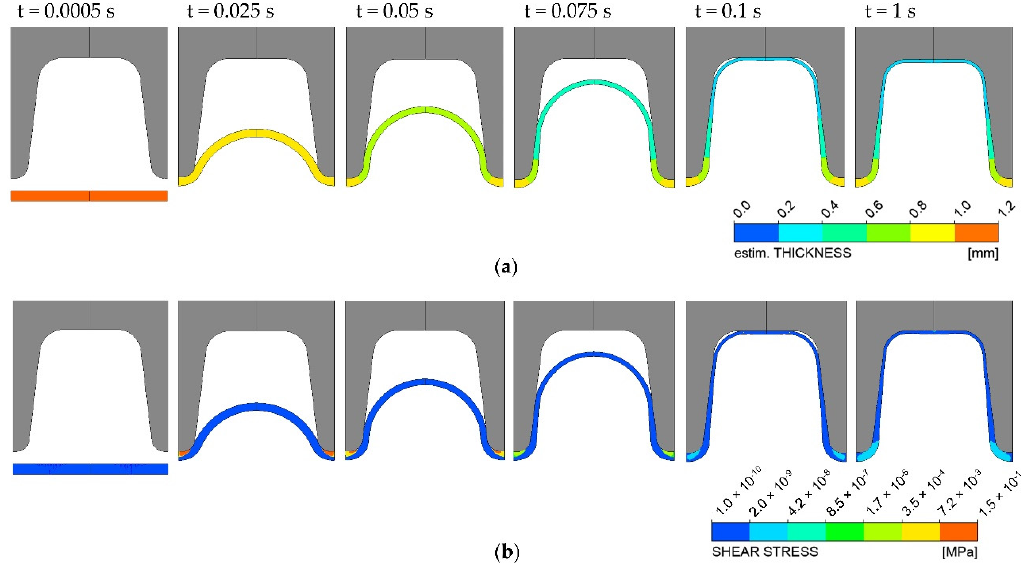
Figure 5. Simulation results of the blow-molding process showing that the parison is fully inflated after an inflation time of 1 s: ( a ) wall thickness distribution, ( b ) shear stress distribution.